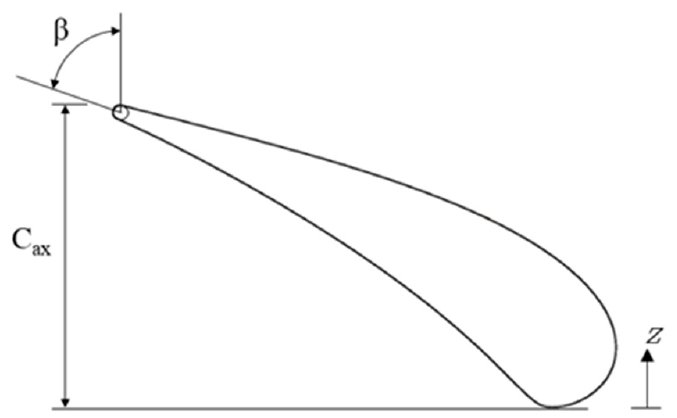
Figure 1. Nozzle guide vane